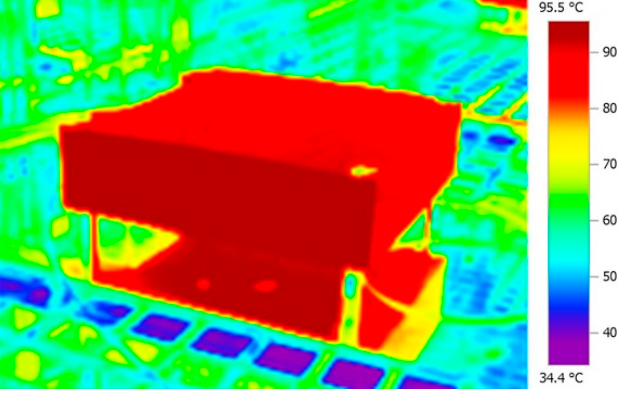
Figure 9. EDFA under high-temperature vacuum test.